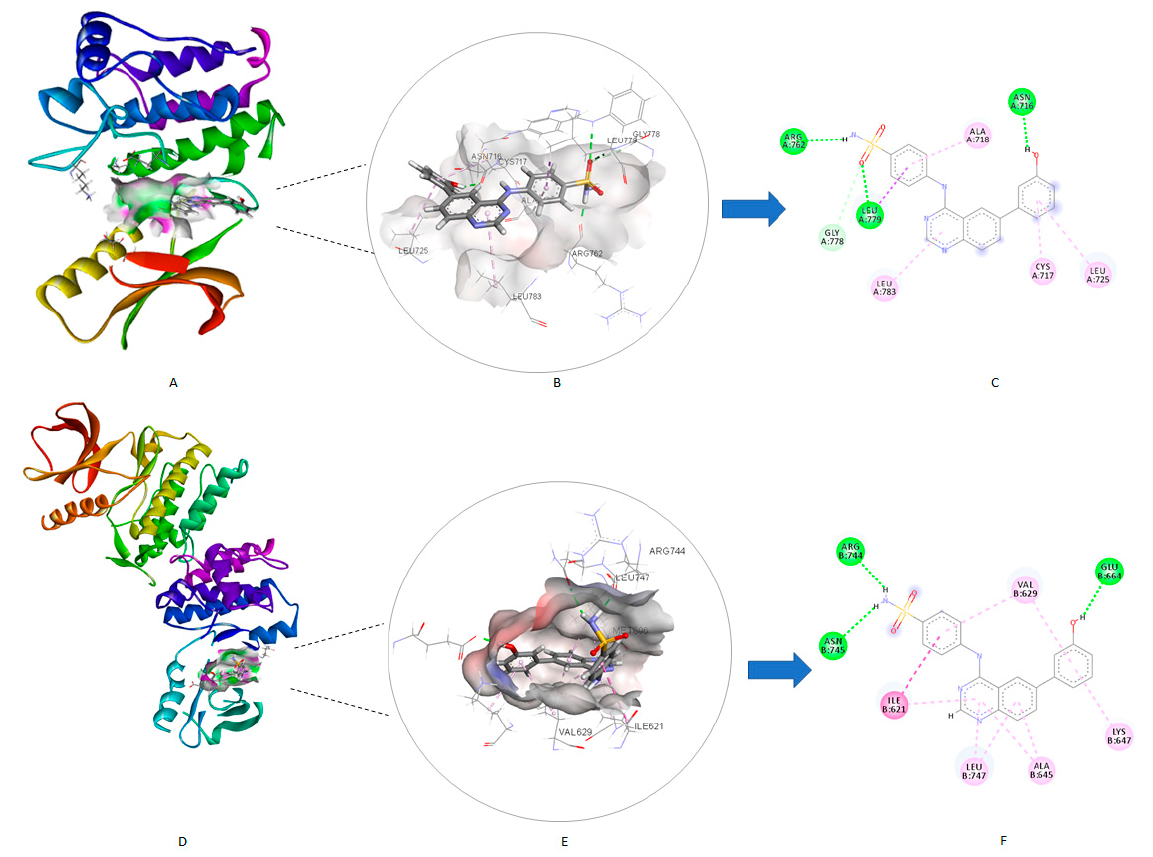
Figure 8. Docked complexes of compounds 4c with EphB3 and EphB4 isoforms: ( A ) 3D model of the crystal structure of EphB3 with compound 4c ; ( B ) 3D docking model of compound 4c into EphB3 binding pocket; ( C ) 2D interaction diagram of compound 4c with EphB3 active site; ( D ) 3D model of the crystal structure of EphB4 with compound 4c ; ( E ) 3D docking model of compound 4c into EphB4 binding pocket; ( F ) 2D interaction diagram of compound 4c with EphB4 active site.